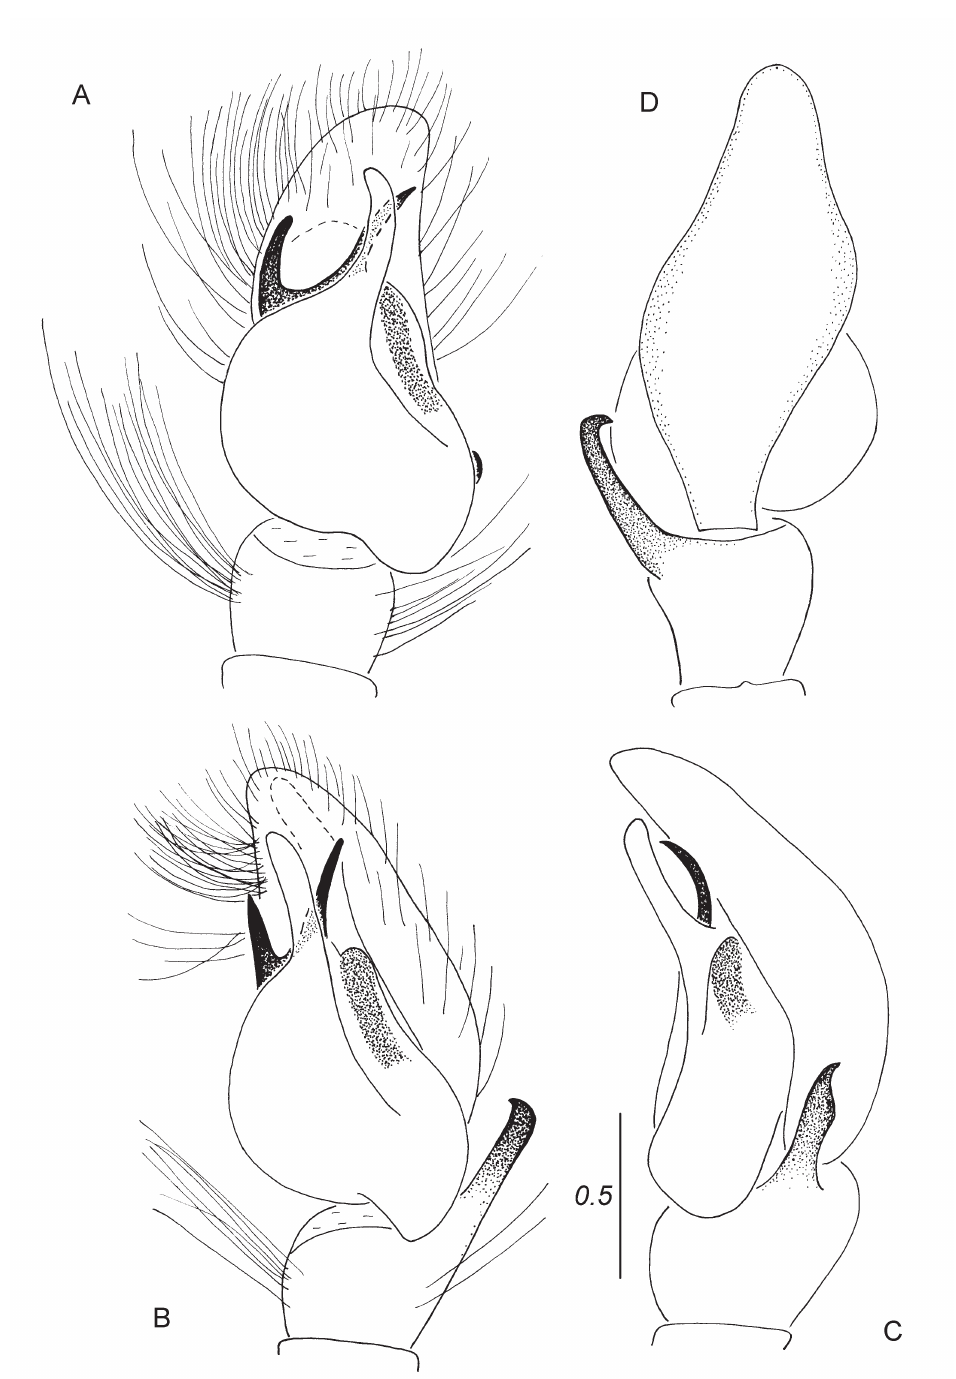
Fig. 2. Thiratoscirtus oberleuthneri sp. nov., holotype, palpal organ. A . Ventral view. B . Ventrolateral view. C . Lateral view. D . Dorsal view. scale bar for all figures = 0.5